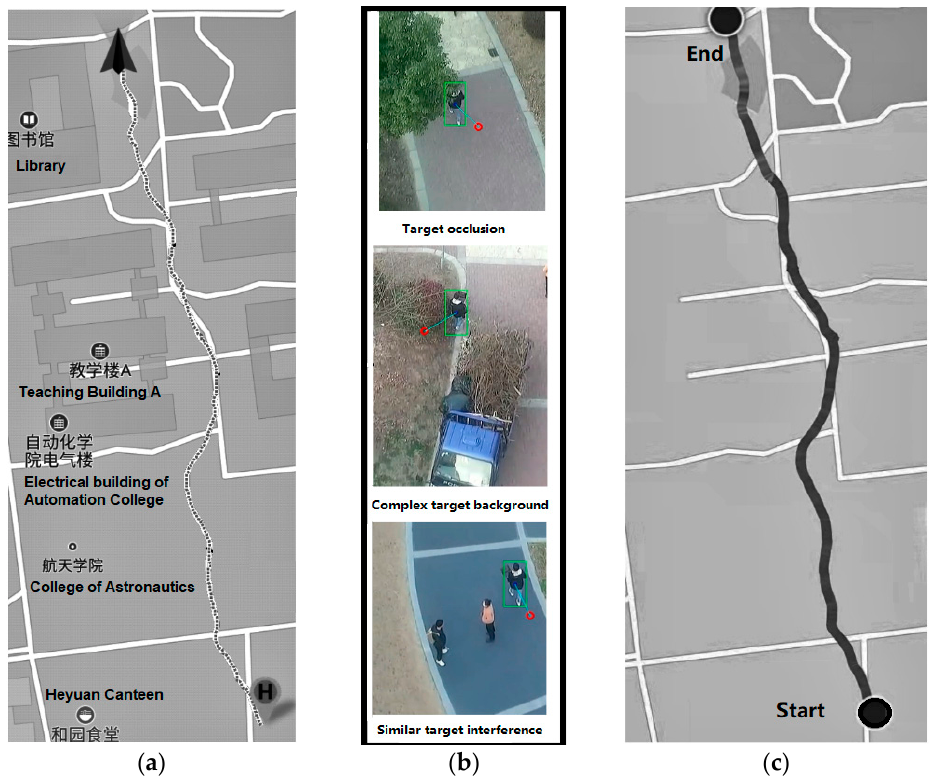
Figure 15. Target tracking in complex environment ( a ) UAV trajectory; ( b ) Real-time tracking image of UAV; ( c ) Target trajectory.